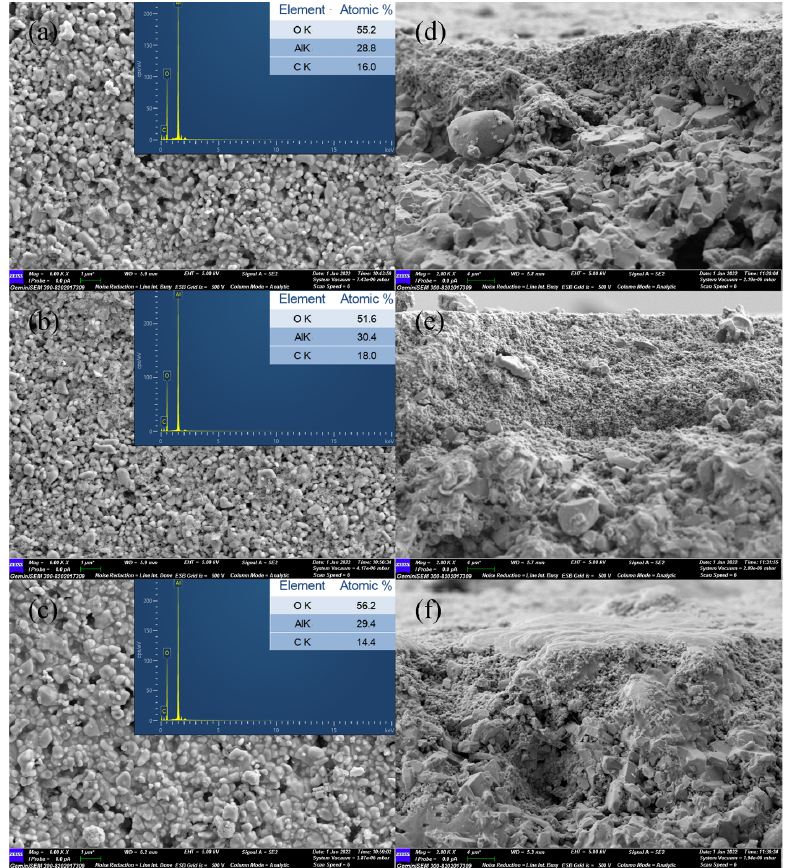
Figure 6. SEM and EDS images of the surface of ACMs after cleaning: ( a ) 30 mg·L −1 ; ( b ) 40 mg·L −1 ; ( c ) 50 mg·L −1 ; SEM images of the surface of ACMs after cleaning: ( e ) 30 mg·L −1 ; ( d ) 40 mg·L −1 ; ( f ) 50 − 1 ; SEM images of the surface of ACMs after cleaning: ( e ) 30 mg · L − 1 ; ( d ) 40 mg · L − 1 ; mg L −1 . ( c ) 50 mg · L ( f ) 50 mg L − 1